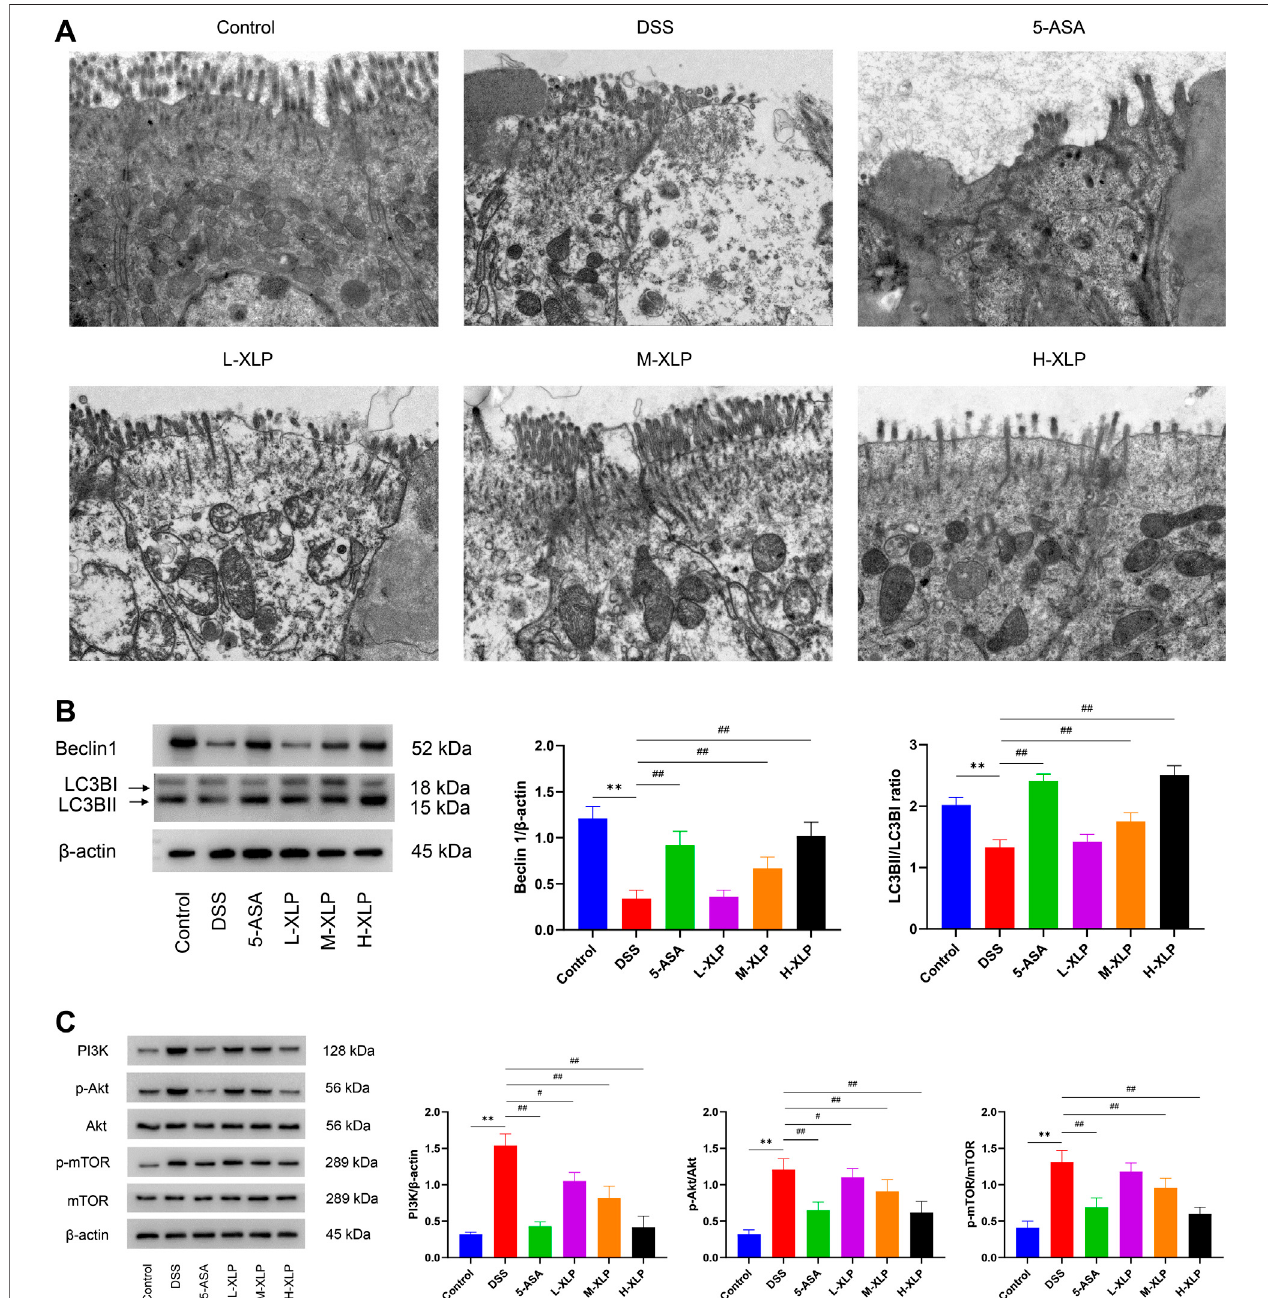
FIGURE 5 | Xianglian pill enhanced autophagy by blocked the activation of PI3K/Akt/mTOR pathway in DSS-induced colitis mice. (A) Autophagosomes in colon tissue from each group were detected and observed under a transmission electron microscopy ( × 5000). (B) Expression of Beclin-1 and LC3B in colon tissues were detectedbywesternblotanddatawereexpressed asfoldchangeinprotein expression normalized to β -actin expression ortheratioofLC3BII/LC3BI. (C) Expressionof PI3K, p-Akt,Akt, p-mTOR,and mTORincolontissuesweredetected bywesternblotanddatawereexpressed asfoldchangeinproteinexpression normalized to β -actin expression. * p < 0.05, ** p < 0.01 vs. control group, # p < 0.05, ## p < 0.01 vs. DSS group.